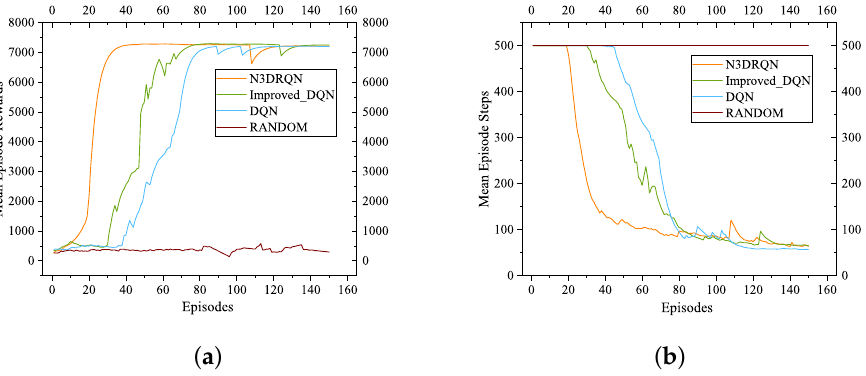
Figure 4. Mean rewards versus training episodes in the Chain-20 environment. ( a ) Mean episode rewards in the Chain-20 environment. The horizontal axis represents the cumulative number of episodes used by the agent to execute the action. The vertical axis represents the cumulative rewards as the agent interacting with environment. ( b ) Mean episode steps in the Chain-20 environment. The horizontal axis represents the cumulative number of episodes used by the agent to execute the action. The vertical axis represents the number of steps decided by the agent per